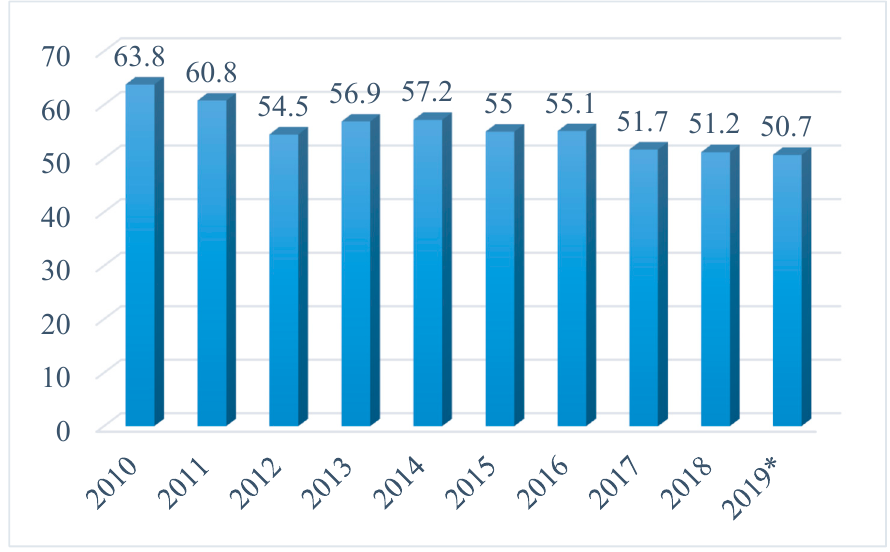
Figure 5. Czech self-sufficiency rate with regard to pig meat (in %) (*—prediction) [30].